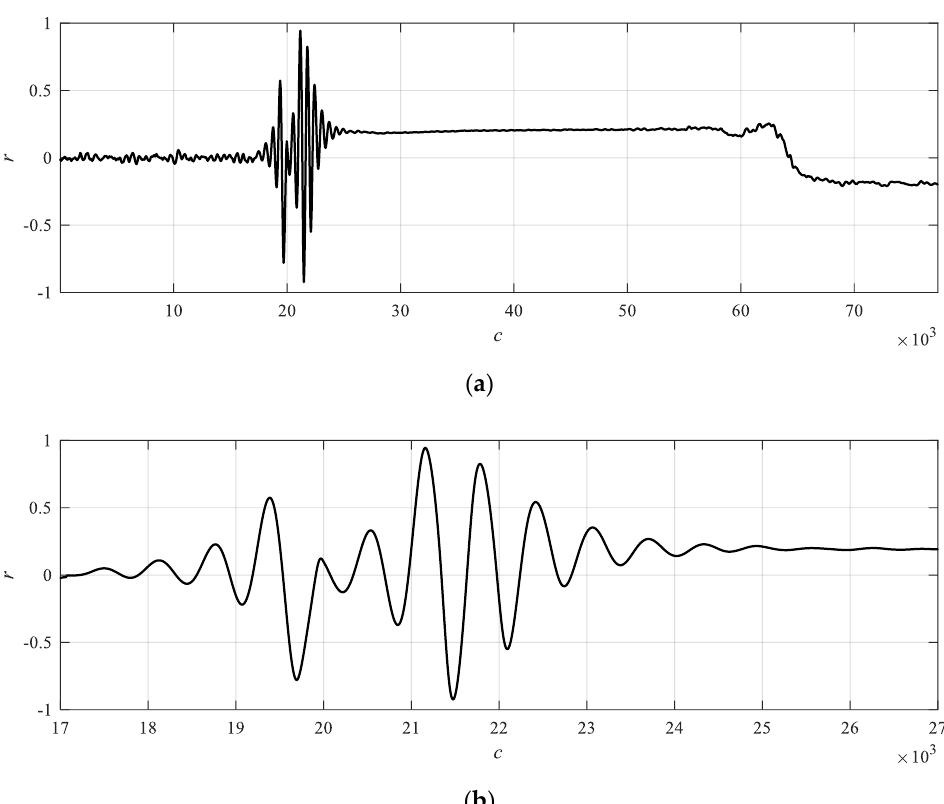
Figure 11. Determining the correlation for sample measurement data, delay c = 22,000.